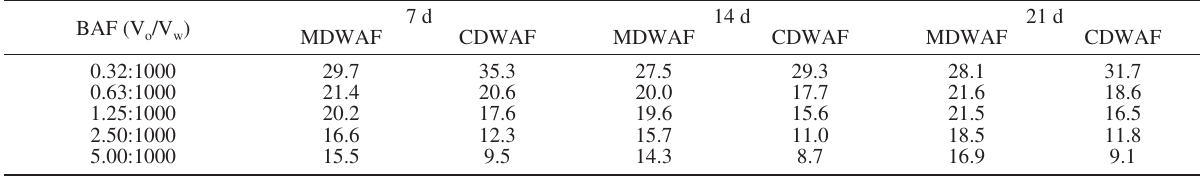
Table 4. – Bioaccumulation factor for MDWAF and CDWAF